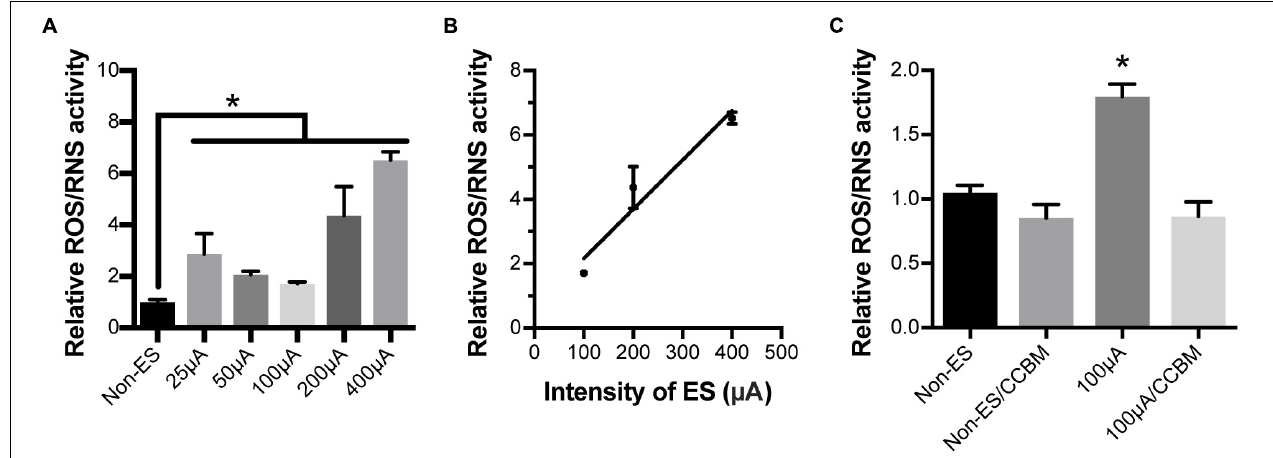
FIGURE 6 | Electrical stimulation increased ROS/RNS activity in cochlear explants but inhibiting calcium influx completely abolished this effect. (A) ROS/RNS activity of explants under 25, 50, 100, 200, and 400 µ A ES for 48 h was significantly higher than that of non-ES explants. ∗ P < 0.05 when compared with non-ES group, n = 3 in each group, measurements were repeated three times. (B) ROS/RNS activities increased in an ES intensity-dependent manner. Pearson’s test, r = 0.9691, P = 0.1587 (two-tailed). (C) When 100 µ A/48 h ES-treated cochlear explants were also treated with CCB mixture (CCBM), the level of ROS/RNS activity was comparable to that in non-ES explants. ∗ p < 0.001 when compared with any other group, n = 3 in each group, measurements were repeated three times. Data represented the mean +